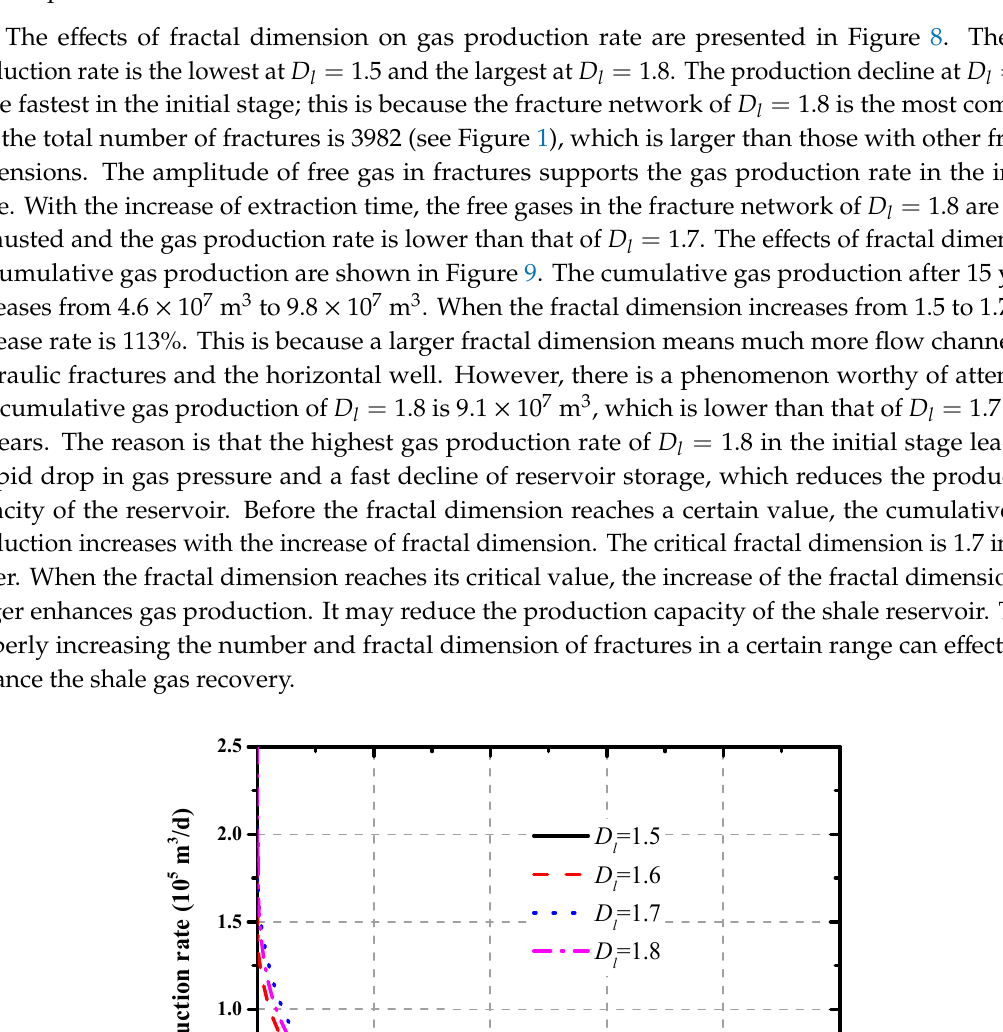
Figure 9. Cumulative gas production from the fracture network with different length fractal dimensions. 4.2 Effects of Pore Size Distribution A large quantity of gas stores in shale matrix pores and plays an important role in gas production. Thus, the effects of pore size distribution on gas production should be investigated. Figure 10 shows the effects of maximum pore diameter